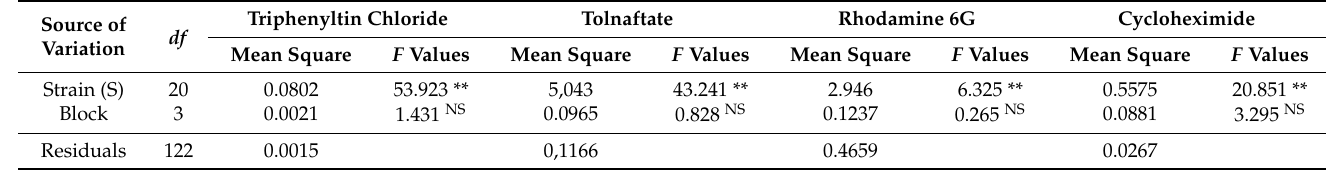
Table 1. Analysis of variance of the effect of strains on the EC 50 values for efflux pump